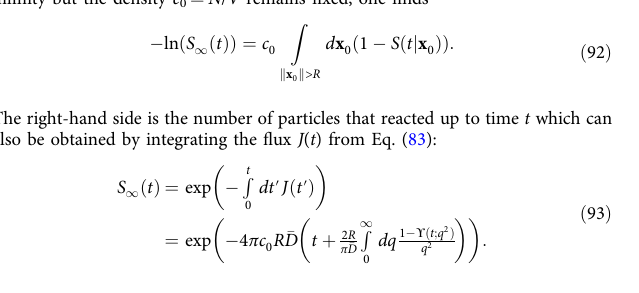
Fig. 8 The macroscopic reaction rate for the interior of a ball. The diffusive Fig. 7 The macroscopic reaction rate for the exterior of a ball. The diffusive fl ux J ( t ) onto the perfectly reactive surface of a ball of radius R , from Eq. fl ux J ( t ) onto the perfectly reactive boundary of a ball of radius R from Eq. (90), normalized by the Smoluckowski steady-state rate J S from Eq. (85), (83), normalized by the steady-state Smoluchowski rate J S from Eq. (85). with the uniform initial concentration c 0 inside the ball, ν = 2 ( a ) and ν = The disorder scale μ takes 64 values in the logarithmic range from 10 − 1 0.5 ( b ) and 64 values of μ in the logarithmic range between 10 − 1 and 10 1 (dark blue) to 10 1 (dark red), as indicated in the colorbar. The shape (curves encoded by color, ranging from dark blue to dark red, as shown by parameter ν is set to 2 ( a ) or 0.5 ( b ). The mean diffusivity (cid:1) D is fi xed, colorbar). Thick black line shows the macroscopic reaction rate for whereas two other parameters of the model are τ ¼ R 2 μ 2 ν = (cid:1) D and σ ¼ (cid:1) D = ð R μ ν Þ . The upper black curve presents the fl ux J t )/ J S from Eq. hom ( (84) for homogeneous diffusion (corresponding to μ = 0), whereas the lower red curve shows the asymptotic relation (88) corresponding to